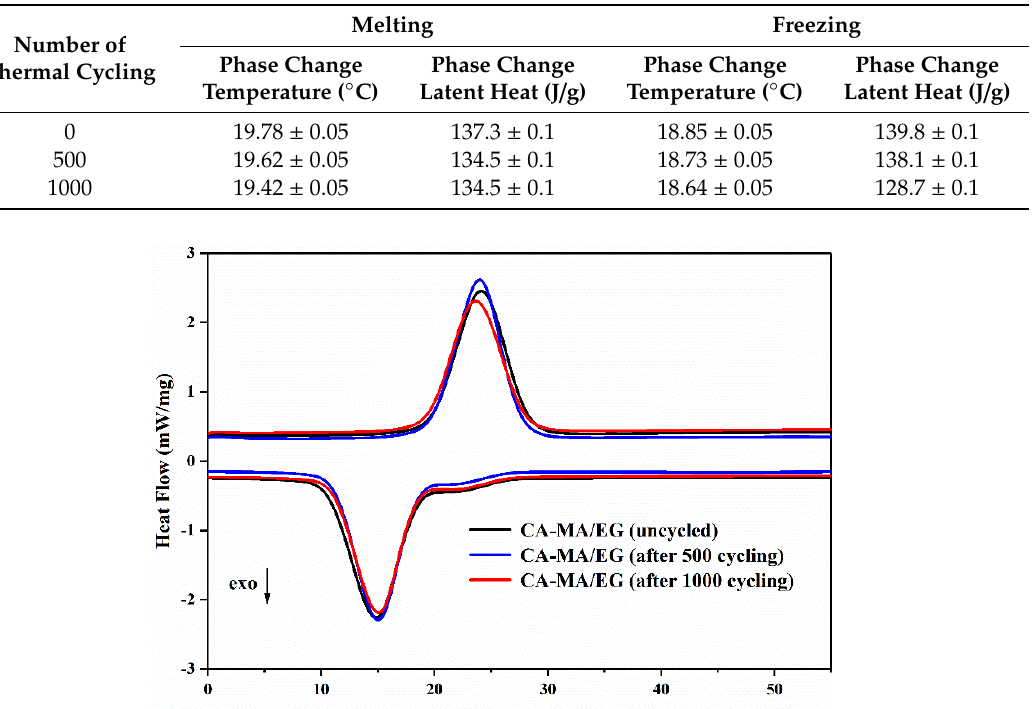
Figure 7. DSC graphs of CA–MA / EG CPCMs before and after thermal cycling.